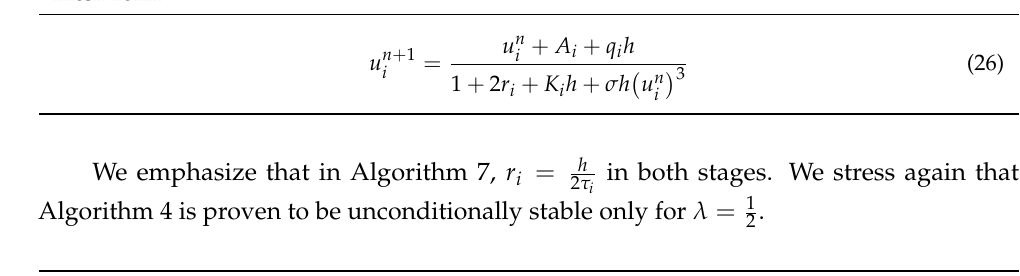
Algorithm 6: (Algorithm 2) UPDF for the diffusion-reaction-radiation equation, general